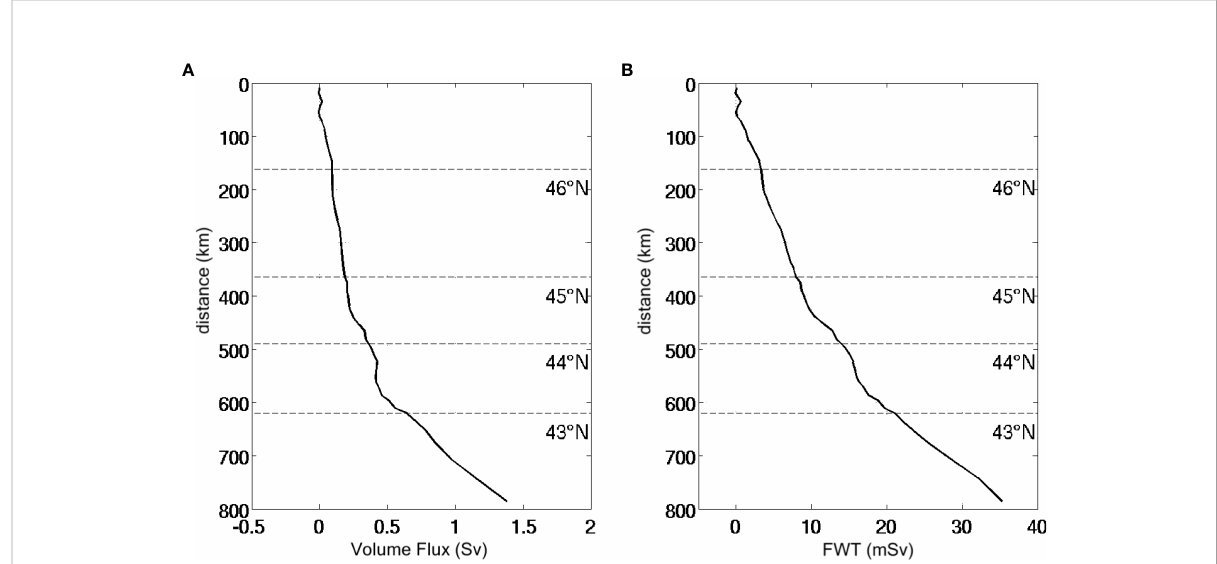
FIGURE 5 The cumulative time-mean (A) volume fl ux and (B) FWT, along section D starting from its northern endpoint at 47°N. The vertical axis is the distance from a location on section D to the northern endpoint, with the corresponding latitudes marked with the horizontal dashed